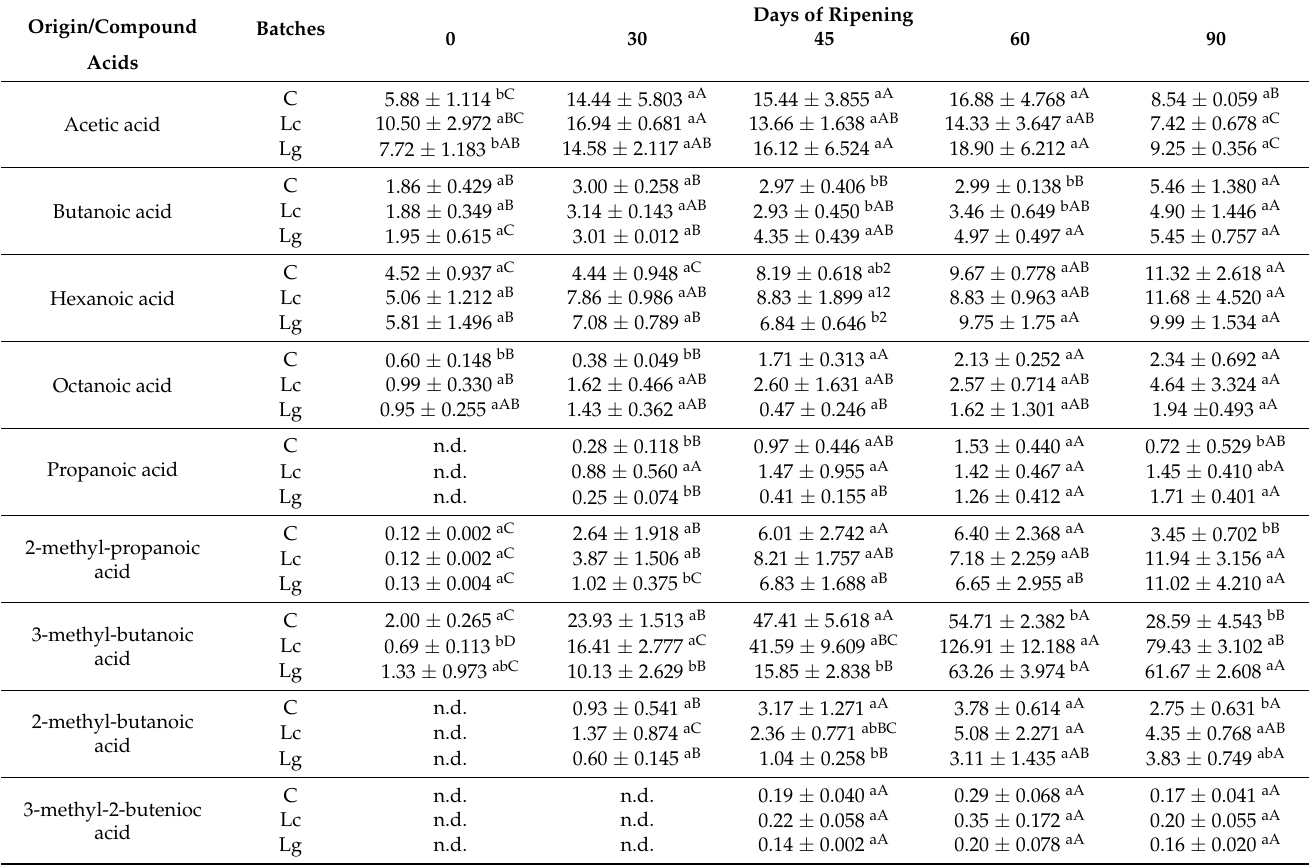
Control (uninoculated batch), Lc (batch inoculated with Lacticaseibacillus casei ) and Lg (batch inoculated with Lactococcus garvieae ). Values are expressed as mean ± standard deviation. Mean values with different lowercase letters indicate significant differences ( p ≤ 0.05) between batches at the same day and compound studied. The mean values with different capital letters indicate significant differences ( p ≤ 0.05) between days at the same batch and compound studied. n.d. not